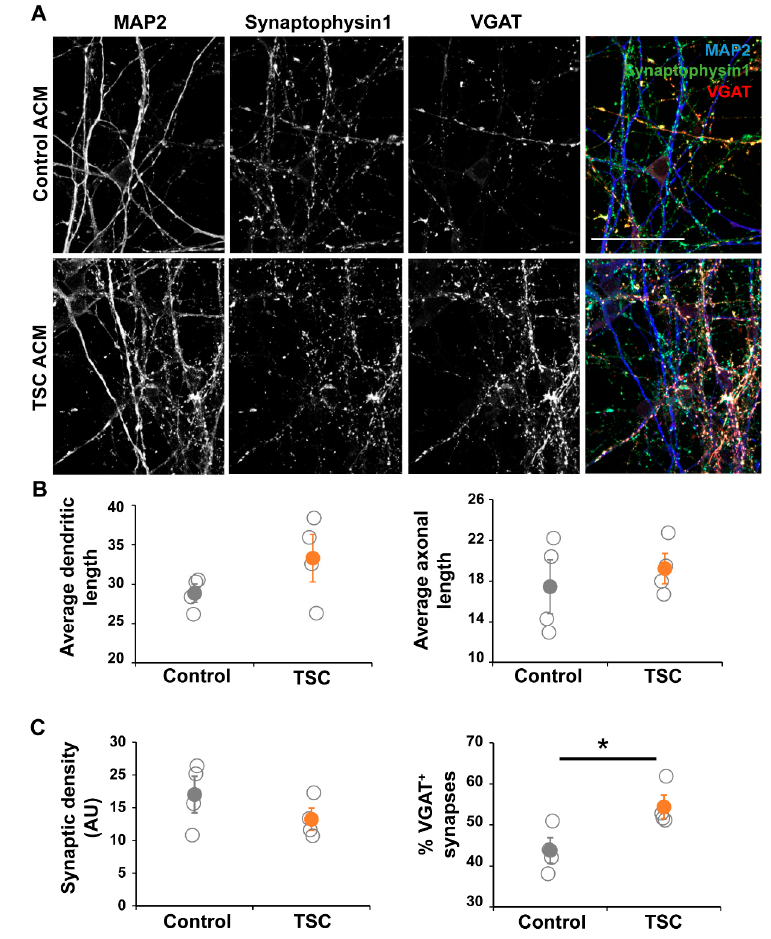
Figure 5. Neurons in TSC ACM show synaptic changes. Control neurons were grown in ACM of either control or TSC astrocytes for 40 days. ( A ) Representative images of immunostaining at the end of the culture (day 57 of neuronal differentiation), showing dendrites by MAP2, all synapses by presynaptic marker Synaptophysin 1, and γ -aminobutyric acid (GABA) synapses by VGAT staining. ( B ) Morphological analysis showed no changes between TSC and control cells. Shown are the results of the average length of dendrites (MAP2 + neurites) and axons (SMI312 + neurites) per cell. ( C ) Synaptic analysis showed no significant changes in synaptic density, but the percentage of VGAT + synapses was significantly increased in cultures with TSC ACM. ACM = astrocyte-conditioned medium, AU = arbitrary units. ( A ) Confocal images, scale bar = 50 μ m ( B , C ) data points represent data for each iPSC line (average of two experiments) with solid data points representing the mean per condition ± SEM. * = p < 0.05 Statistical test: independent samples t -test.